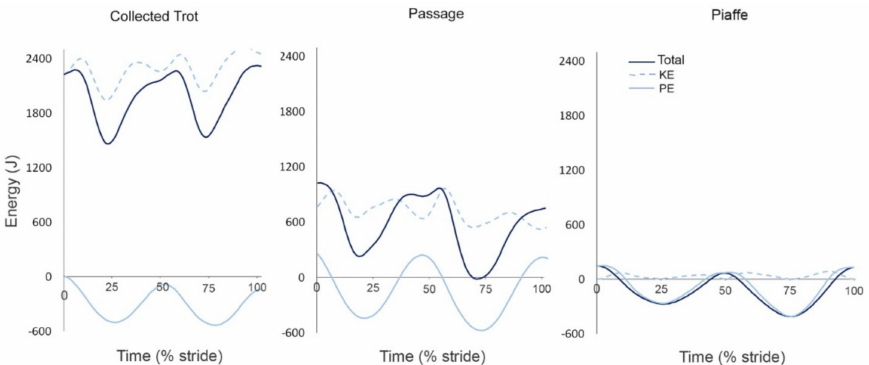
Figure 6. Changes in total mechanical energy (solid dark line), total kinetic energy (KE, dashed light line) and potential energy (PE, solid light line) during one stride of collected trot ( left ), passage ( center ) and pia ff e ( right ). The data are for one stride, starting and ending at hind contact. The scale on the y axis is the same for all graphs. The x axis is scaled to percentage of stride but its length is proportional to the absolute stance duration for each gait. Values for KE are absolute. Values for PE are reported as changes compared to